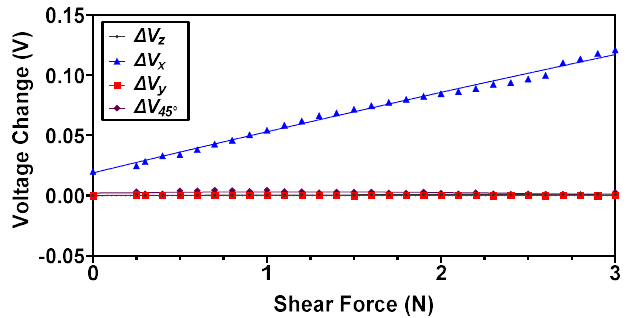
Figure 12. The output voltage response of the proposed magnetic tactile sensor for an applied shear